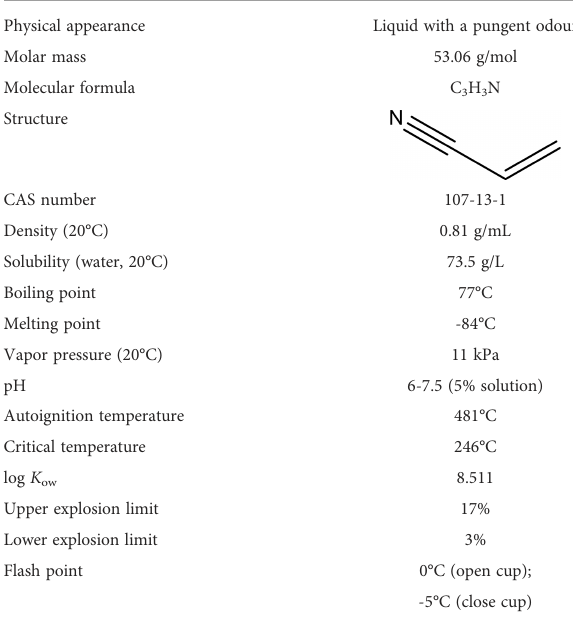
TABLE 3 Physico-chemical characteristics of ACN.